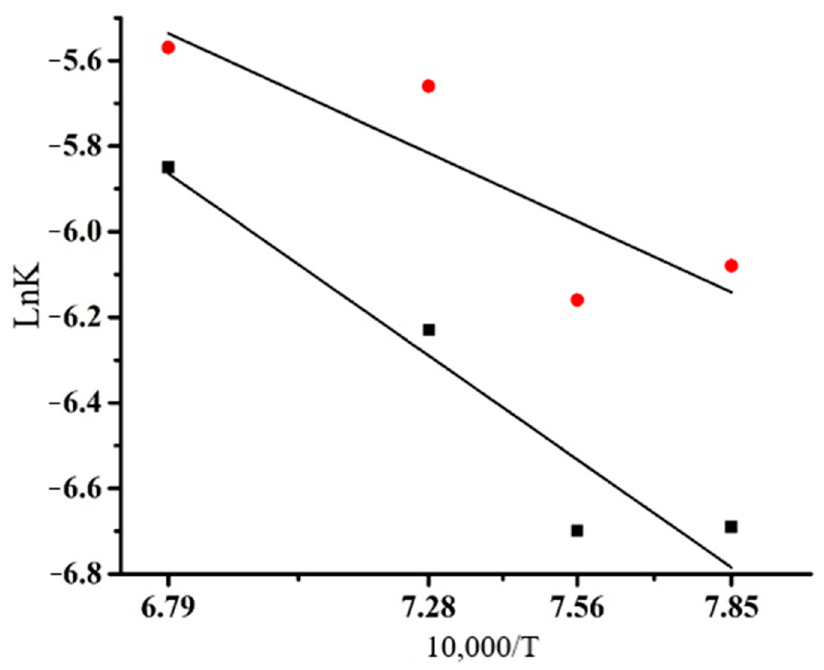
Figure 3. Plot of LnK against 10,000/T (black points—without additives, red points—with Na 2 SO 4 additive).